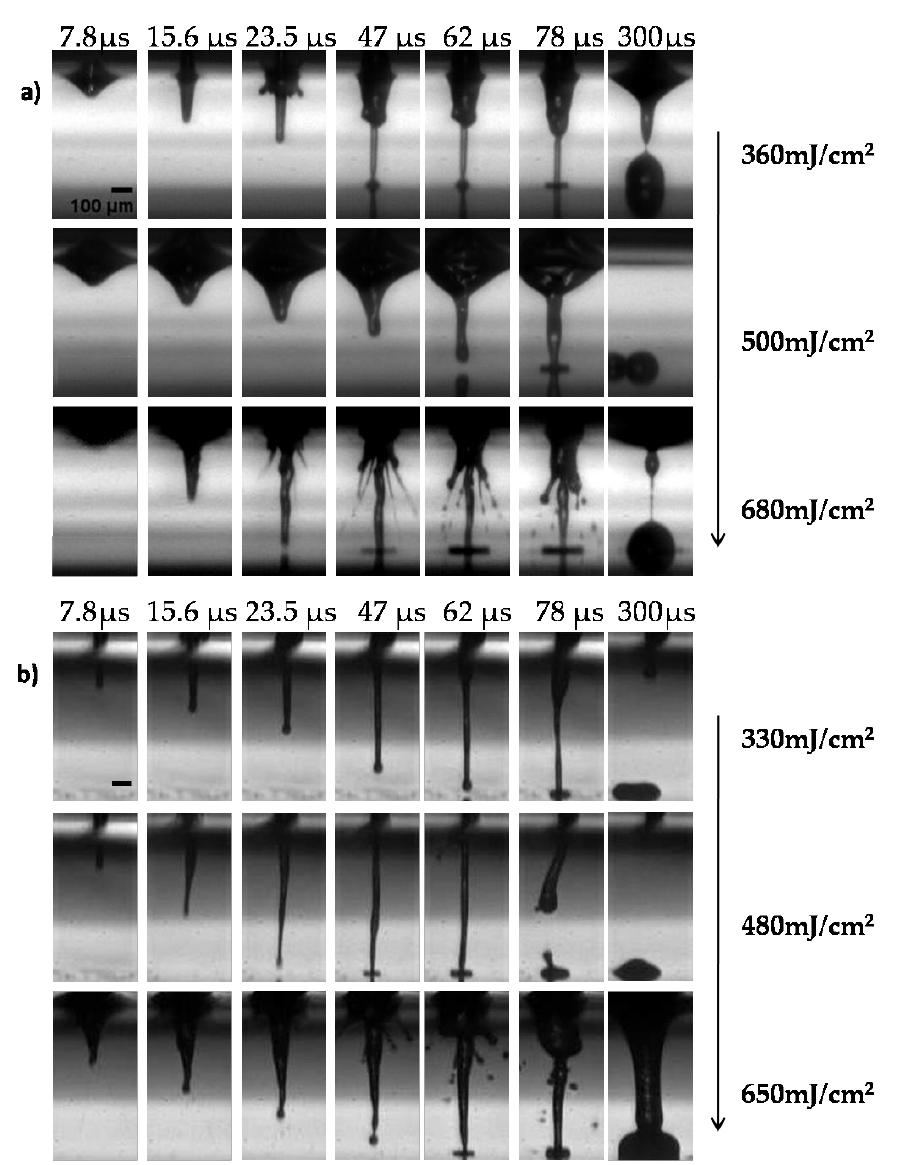
Figure 2. Visualization of the jet dynamics induced by laser pulses with different wavelengths ( a ) at 532 nm and 0.6 ns pulse duration, and ( b ) at 355 nm and 10 ns pulse duration at different laser fluencies at the indicated timeframes. Representative images from each condition are depicted. All experiments were conducted in triplicates, n = 5 Scale bar 100 μ m.